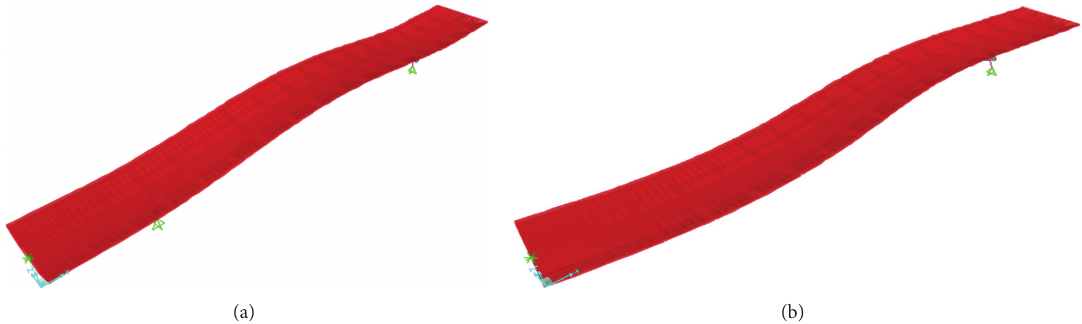
Figure 24: Mathematically identified mode shapes: (a) 1st vertical mode; (b) 2nd transverse mode.